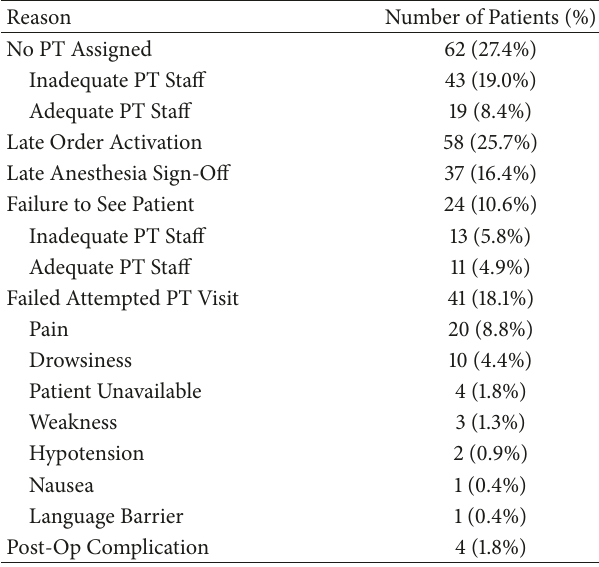
Table 2: Reasons for delayed